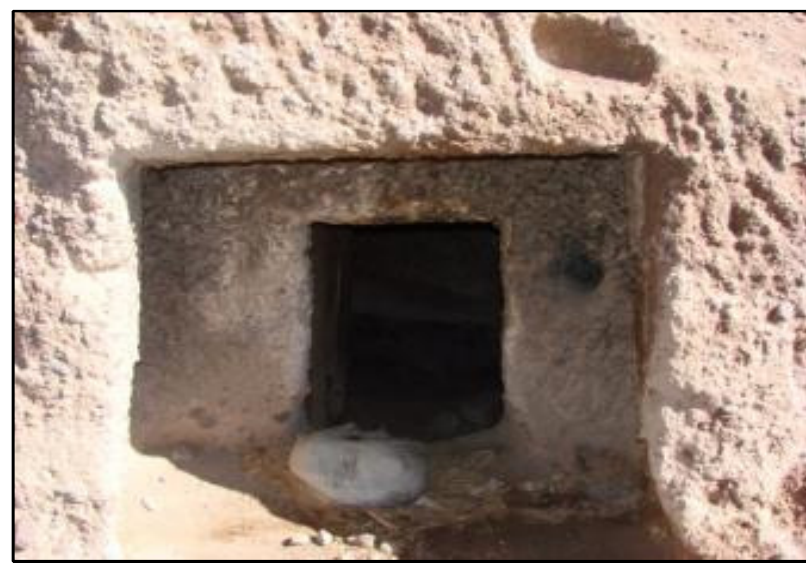
Figure 10. Flat roof in Maymand buildings.